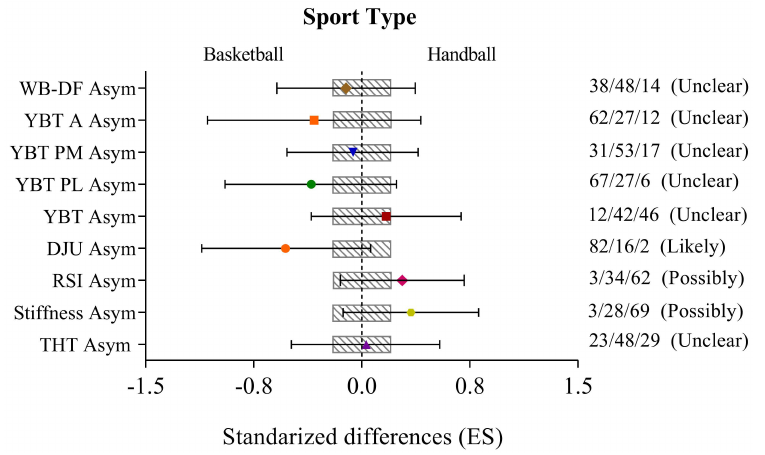
Figure 1. Comparative analysis of mobility, dynamic balance and lower limb strength asymmetries according to the type of sport. The model was adjusted for age. Bars indicate uncertainty in the true mean changes with 90% confidence intervals. Trivial (shaded) areas were calculated from the smallest worthwhile change. Quantitative chances of better or worse effects were determined as follows: <1%—almost certainly not; 1–5%—very unlikely; 5–25%—unlikely; 25–75%—possible; 75–95%—likely; 95–99%—very likely; and >99%—most likely [25,26]. Asym—asymmetry; WB- DF—weight-bearing dorsiflexion; YBT A—Y-balance test anterior reach; YBT PM—Y-balance test posteromedial reach; YBT PL—Y-balance test posterolateral reach; YBT—Y-balance test composite of all directions; DJU—drop jump unilateral; RSI—reactive strength index; THT—triple hop test; Int. J. Environ. Res. Public Health 2021 , 18 , x FOR PEER REVIEW ES—effect size.